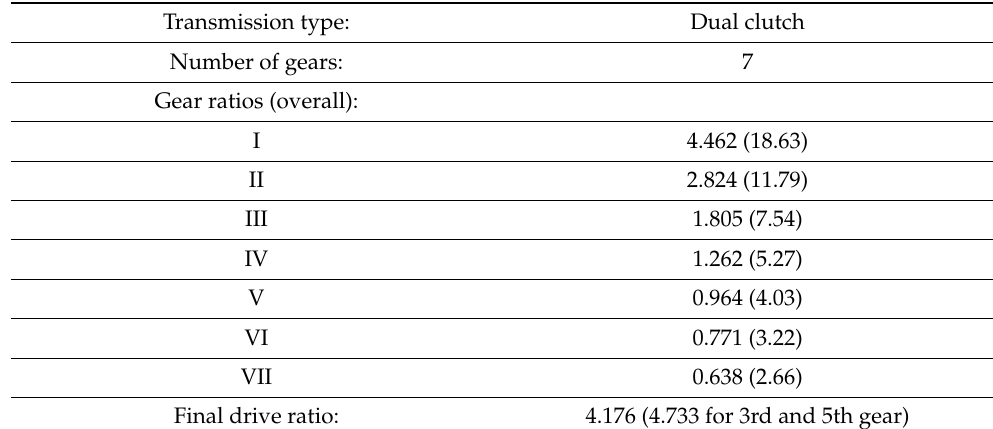
Table A1. 7DCT300 Gear